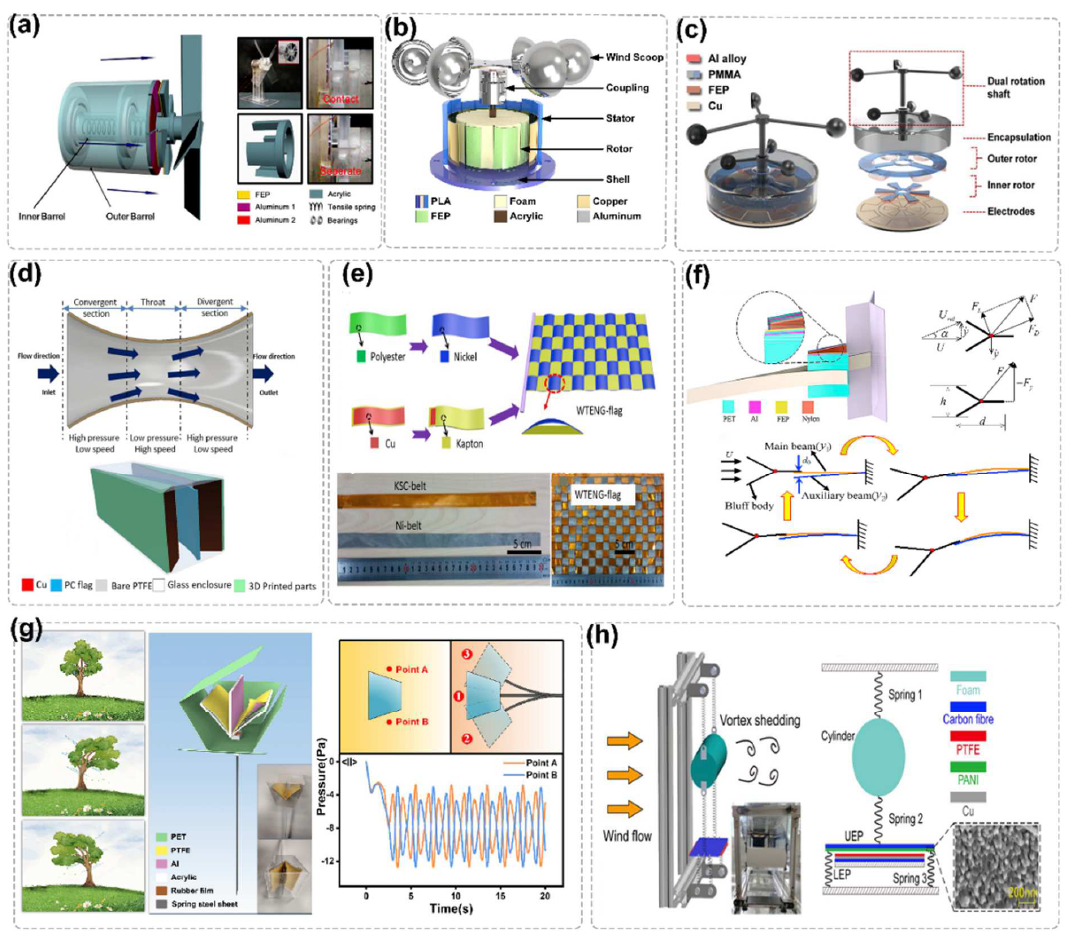
Figure 4. Various structures of WD-TENG: ( a – c ) Rotary structures. ( a ) WD-TENG switching between contact and non-contact modes. Reproduced with permission of [55], Copyright 2015, American Chemical Society. ( b ) Rotary WD-TENG with lightweight rotor. Reproduced with permission of [56], Copyright 2021, Elsevier. ( c ) A dual-rotation shaft WD-TENG. Reproduced with permission of [57], Copyright 2021, John Wiley and Sons. ( d – f ) Structures based on flow-induced vibration. ( d ) TENG based on wind actuated venturi design. Reproduced with permission of [31], Copyright 2019, Elsevier. ( e ) Woven WD-TENG flag. Reproduced with permission of [32], Copyright 2016, American Chemical Society. ( f ) WD-TENG based on galloping response. Reproduced with permission of [35], Copyright 2020, Elsevier. ( g ) WD-TENG based on cantilever beam structure. Reproduced with permission of [33], Copyright 2020, Elsevier. ( h ) Vortex-induced vibration based WD-TENG. Reproduced with permission of [34], Copyright 2022,